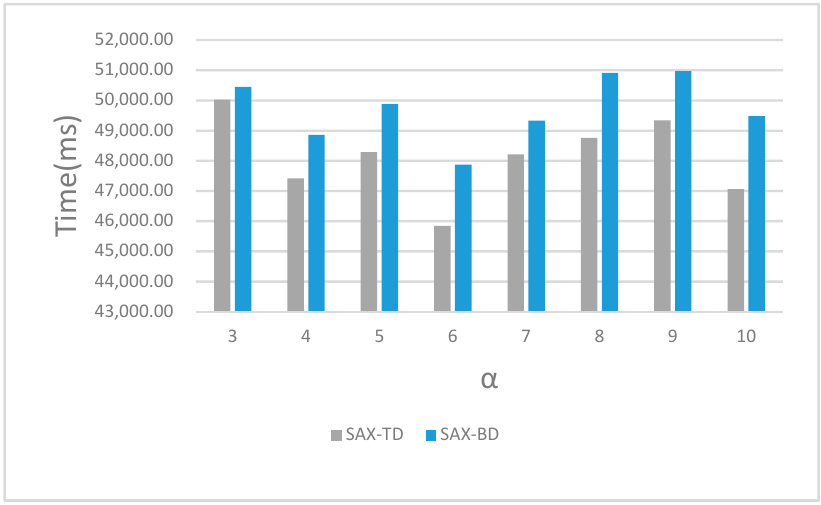
Figure 9. The running time of different methods with different values of α .